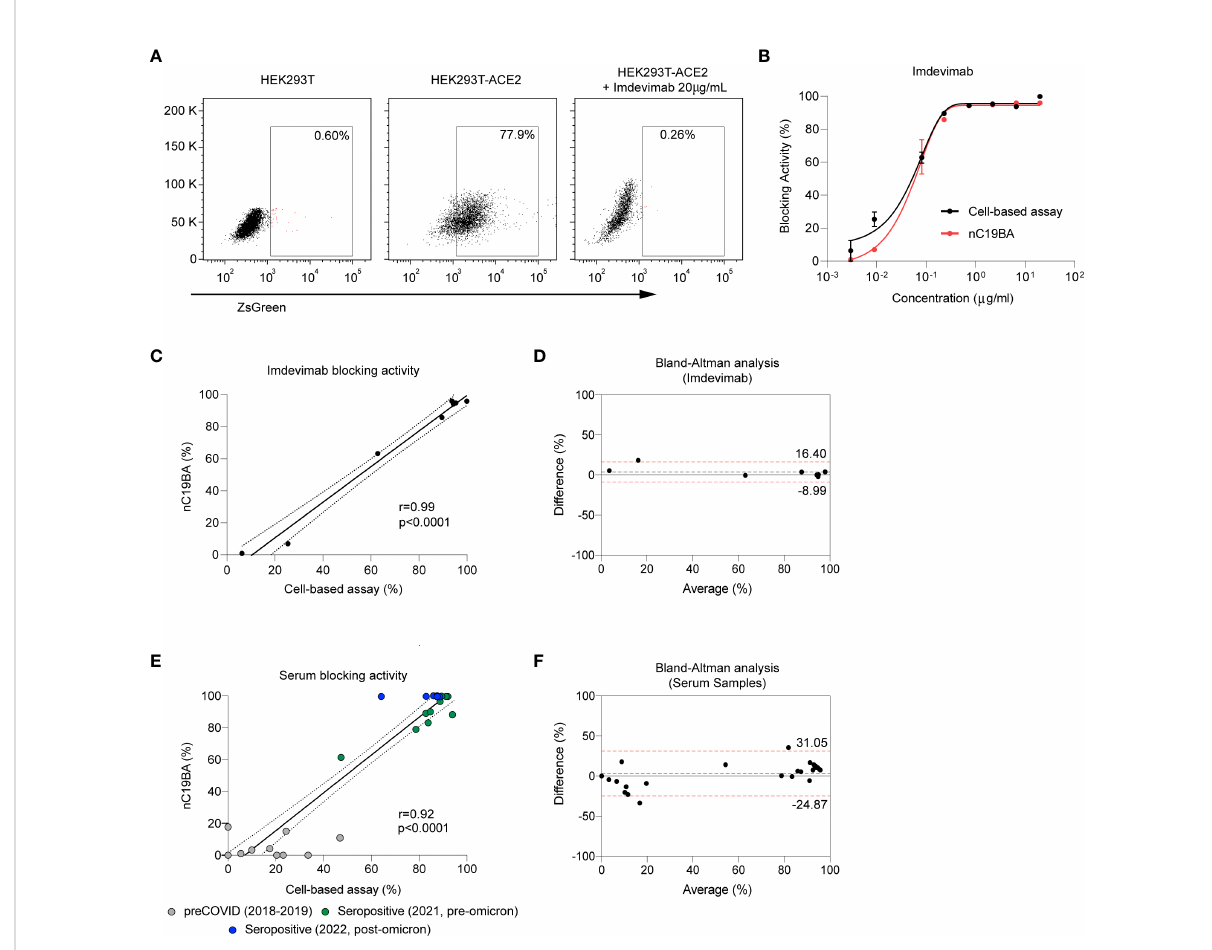
FIGURE 4 Comparison of the performance of nC19BA against a cell-based neutralization assay. (A) Representative dot plots showing the percentage of infected HEK293T (left), HEK293T-ACE2 (middle) and HEK293T-ACE2 cells in the presence of Imdevimab (right), after incubation with pseudotyped viral particles expressing the Spike of SARS-CoV-2, measured by fl ow cytometry. (B) Comparison of the blocking activity achieved by the indicated concentrations of Imdevimab measured by two independent methods: a cell-based pseudotyped lentiviral assay (black) or the bead-based nC19BA assay (red). (C) Pearson correlation corresponding to the blocking activity of Imdevimab measured by nC19BA and a cell-based pseudotyped lentiviral assay. Pearson correlation coef fi cient (r), 95% con fi dence interval and its corresponding p-values are shown. (D) Bland-Altman analysis showing the agreement between nC19BA and a cell-based pseudotyped lentiviral assay for the measurement of the blocking activity of Imdevimab. (E) Pearson correlation corresponding to the blocking activity of preCOVID (n=10) and seropositive (n=18) serum samples corresponding to the indicating cohorts, measured by nC19BA and a cell-based pseudotyped lentiviral assay. Pearson correlation coef fi cient (r), 95% con fi dence interval and its corresponding p-values are shown. (F) Bland-Altman analysis showing the agreement between nC19BA and a cell-based pseudotyped lentiviral assay for the measurement of the blocking activity of serum